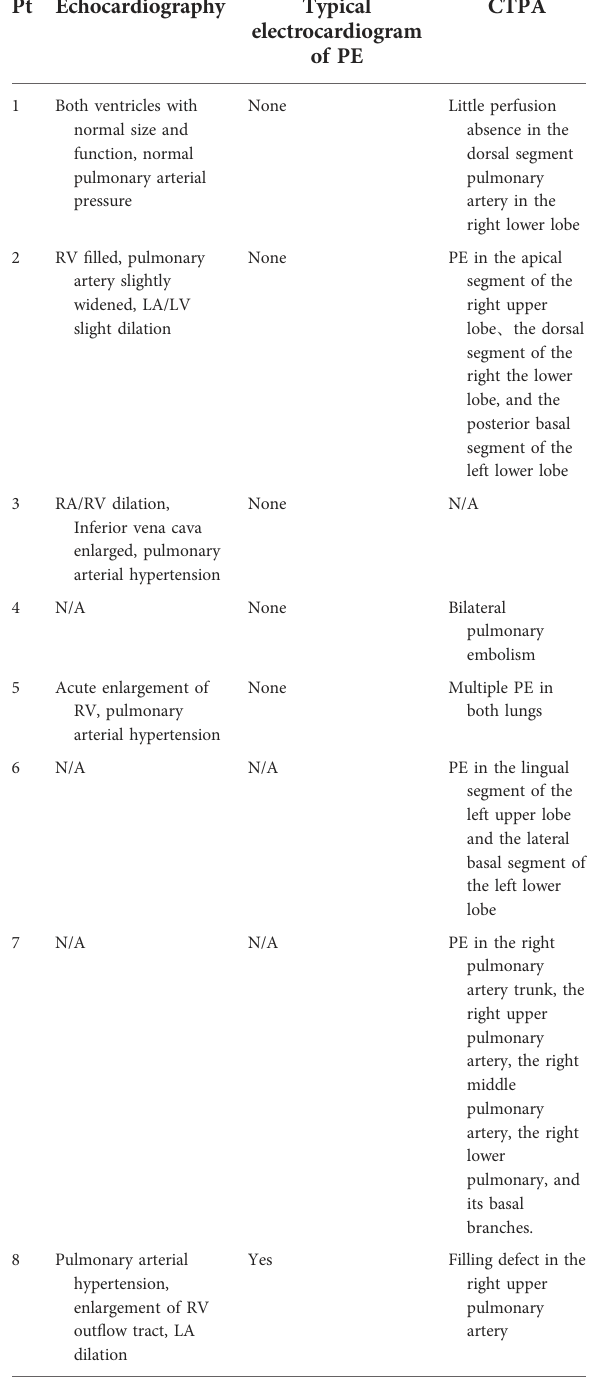
TABLE 4 Main auxiliary examination characteristics related to